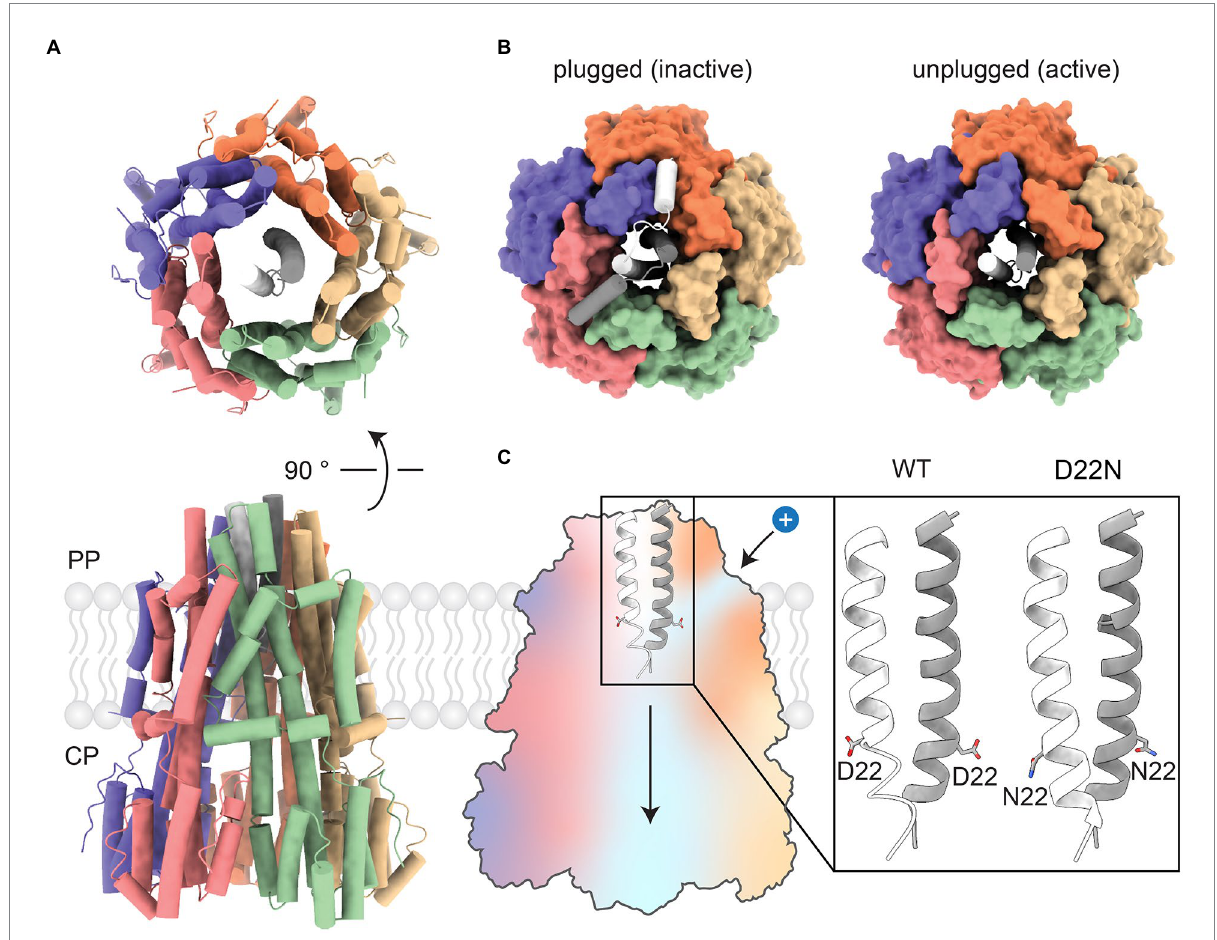
FIGURE 2 Overview of the Cj MotA/MotB complex. (A) Top and front views of the Cj MotA (colored)/ Cj MotB (white and gray) protein complex in 5:2 stoichiometry (PDB ID:6YKP). (B) Comparison of plugged (left, inactive, PDB ID: 6YKM) and unplugged (right, active, PDB ID: 6YKP) complexes. Plugs mechanically block the rotation of the MotA pentamer relative to MotB. (C) (Left) Proton channels for proton influx and dissociation in MotA/B complex are shown as blue areas on the cross-section of the MotA/B complex. (Right) Close-up view of MotB helices with D22 highlighted. Unprotonated side chains of aspartic acid (D22) point upward, facing the proton inlet channel (PDB ID: 6YKP). The protonation- mimetic residue substitution D22N reorients the sidechain of residue 22 downward, enabling MotA/B movement (PDB ID: